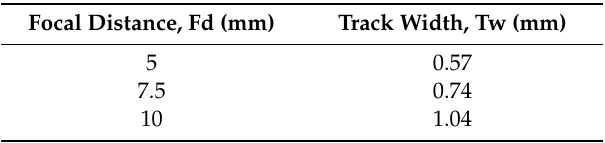
Table 5. Width of laser tracks at di ff erent focal